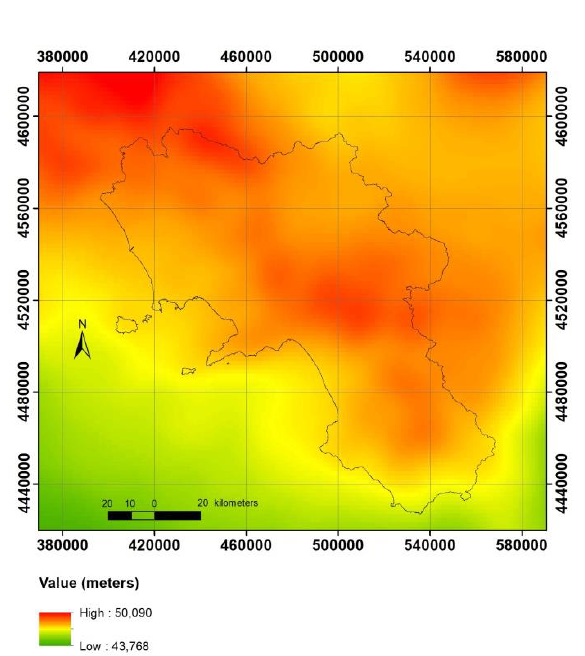
Figure 3. The EGM2008 geoid height model in the study area projected in UTM-WGS84 Zone 33N.